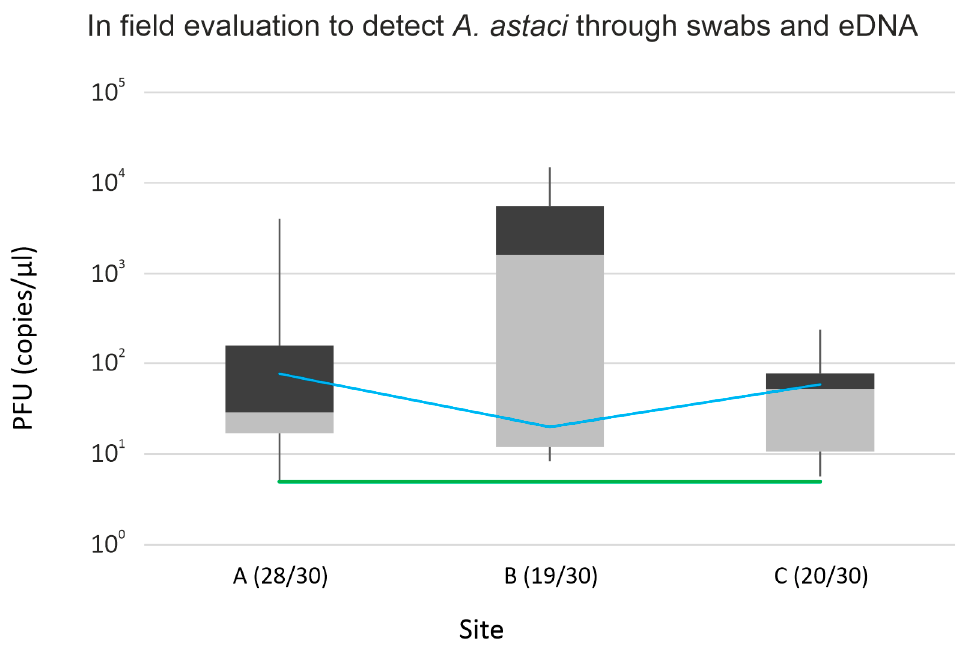
Figure 5. Results of the experimental trial performed in sites A, B and C with the A. pallipes complex. The boxplot represents the variability of A. astaci in swabs through qPCR. The numbers in brackets indicate positive samples on specimens tested (30). The absolute quantifications are expressed as PCR Forming Units (copies/µL). The light blue line indicates the average level of A. astaci in eDNA samples; the green line indicates the LoD level (5.00 × 10 0 copies/µL).